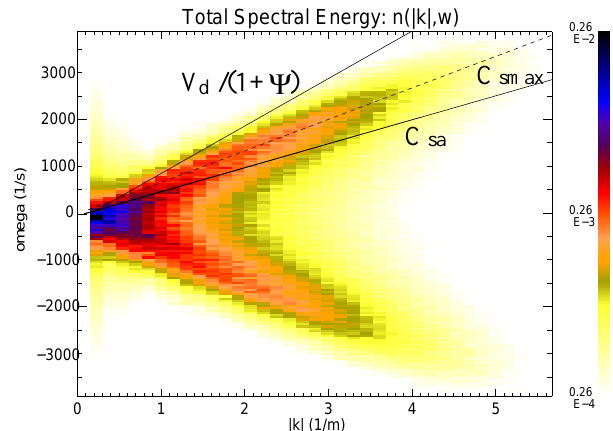
Fig. 7. Power as a function of | k | and ω . This is generated by summing over all the angles from spectra like those seen in Fig. 5. Lines for C sa = 500m/s, V d /( 1 + 9) = 950m/s and C smax = 650m/s (dashed) have been placed on the figure for